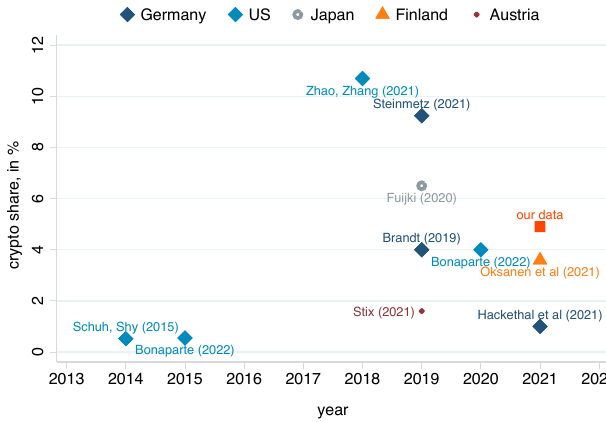
Figure A6. Histograms of age and income. Source: Own data.